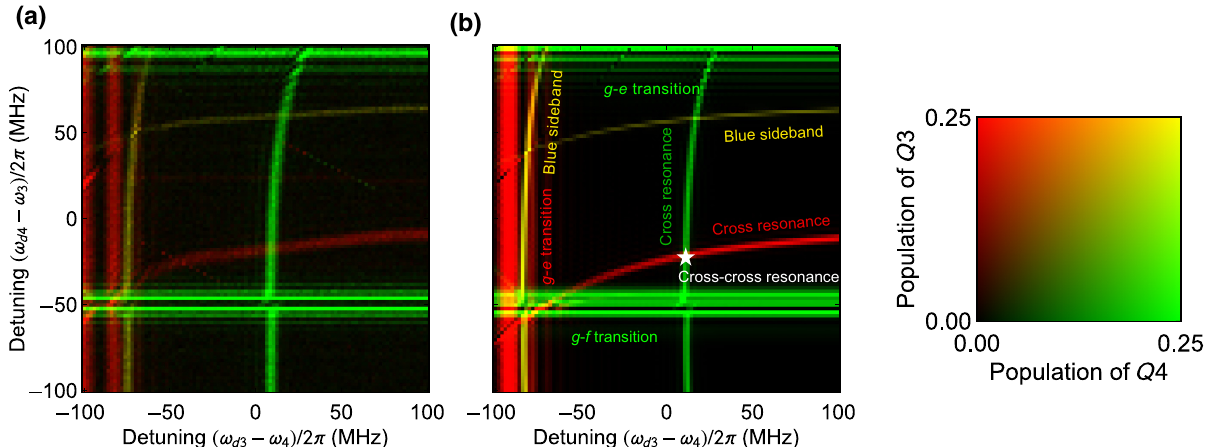
FIG. 1. Heatmaps of qubit excited-state population measured after CCR gates with various frequency detunings from the predeter- mined drive frequencies based on the individual CR gate calibration. (a) Experimental results and (b) simulation results. The measured populations of Q 3 and Q 4 are overlaid in the same plot to highlight an optimal driving point. The excited-state populations of Q 3 and Q 4 correspond to red and green, respectively. The yellow region indicates frequencies at which both Q 3 and Q 4 are simultaneously excited. See the discussion in the main text. In each panel, the vertical (horizontal) axis represents the detuning from the predetermined CR frequency of Q 4 ( Q 3), corresponding to the frequency of the target qubit Q 3 ( Q 4). The labels in (b) indicate the origin of each transition.